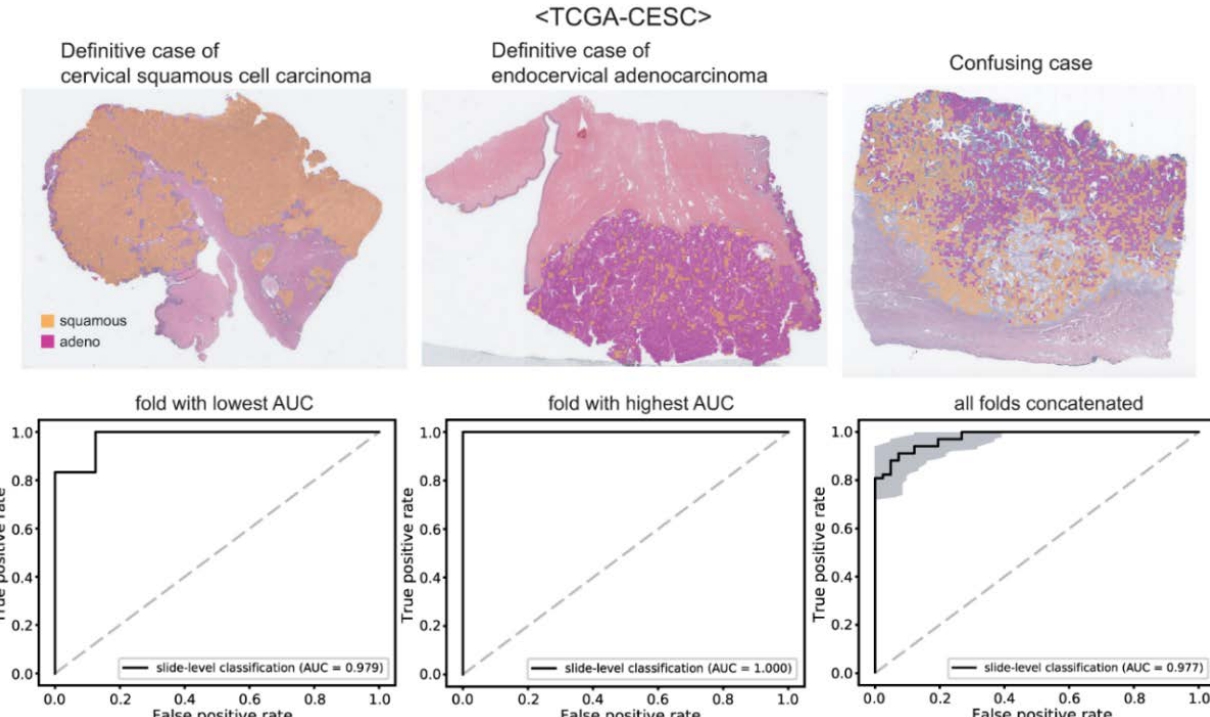
Figure 3. Classification results for cervical cancer subtypes. Upper panels: the representative whole slide images of clear cervical squamous cell carcinoma, clear endocervical adenocarcinoma, and confusing case with mixed classification results. Lower panels: the receiver operating characteristic curves of slide-level classification results for folds with the lowest and highest area under the curve (AUC) and concatenated results of all 5-folds.